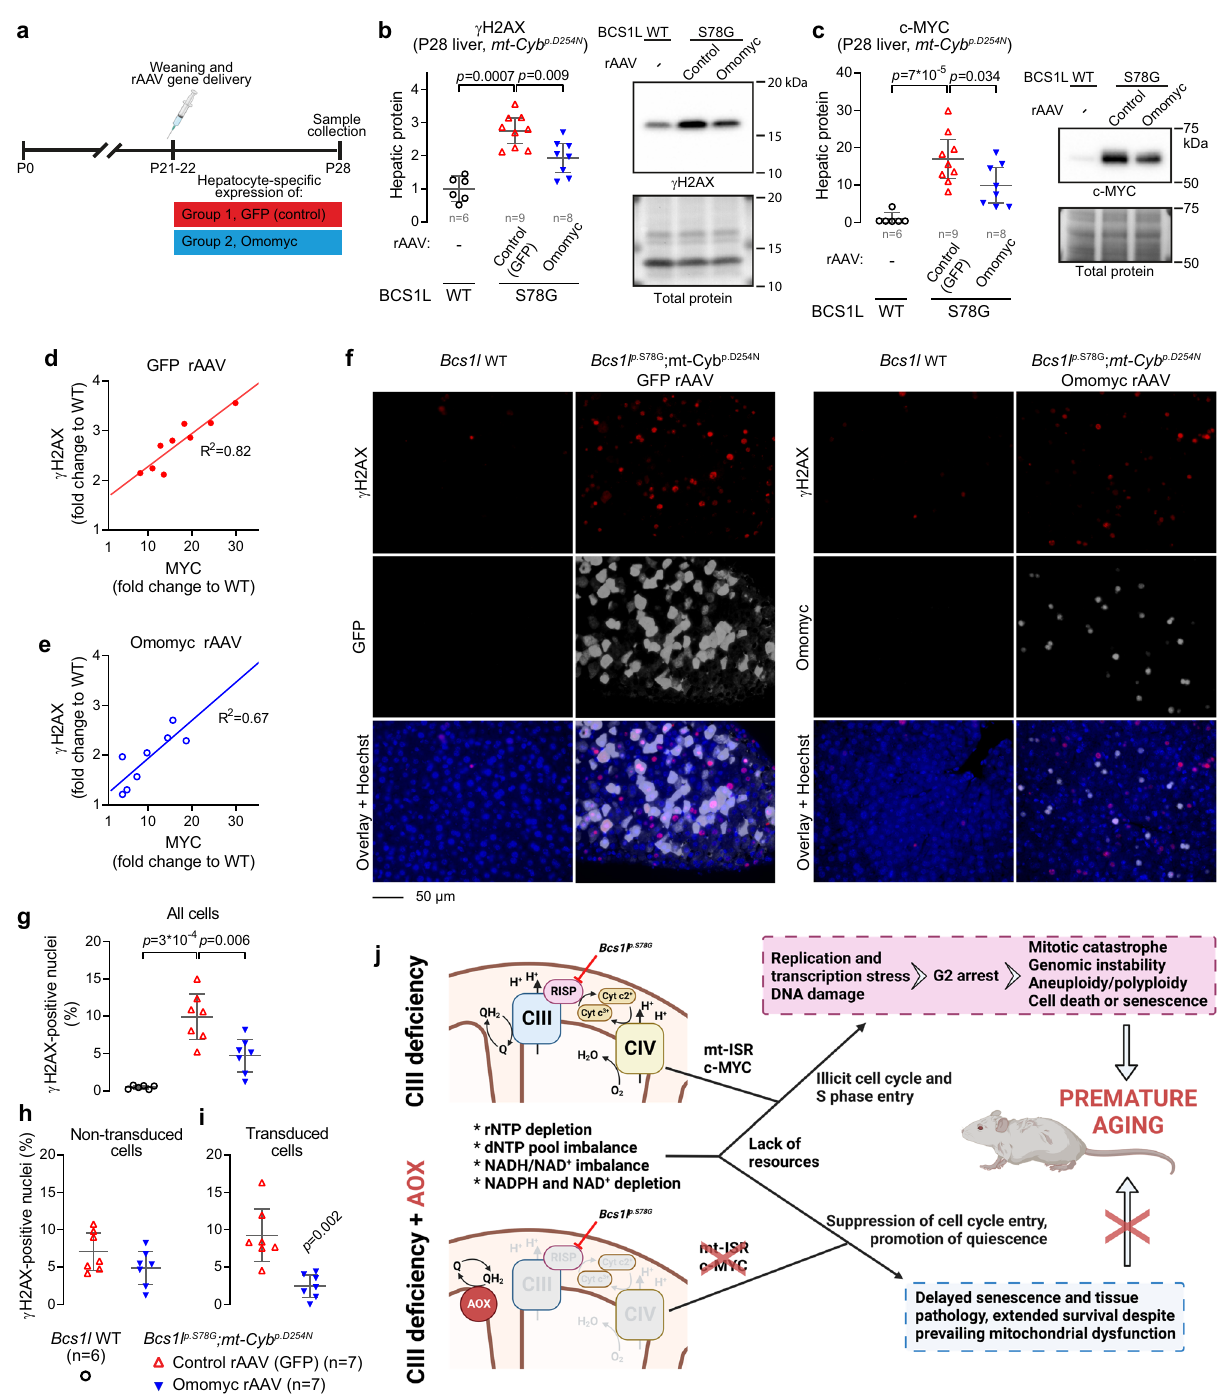
Fig. 10 | Suppression of c-MYC function with dominant-negative Omomyc protein attenuates the CIII de fi ciency-induced DNA damage. a , Timeline of rAAV-mediatedexpressionofOmomycinthehepatocytesof Bcs1l p.S78G ;mt-Cyb p.D254N mice.ThecontrolrAAVexpressedthegreen fl uorescentprotein(GFP)asareporter protein. b , c Western blot quanti fi cation of γ H2AX and c-MYC in liver lysates from Bcs1l WT and rAAV-injected Bcs1l p.S78G ;mt-Cyb p.D254N mice. d , e Correlation between c-MYC expression and H2AX phosphorylation in the liver samples from Bcs1l p.S78G ;mt-Cyb p.D254N miceinjectedwithcontrolrAAV( d )orOmomycrAAV( e ).The data are same as in the fi gures b and c. f Representative liver sections